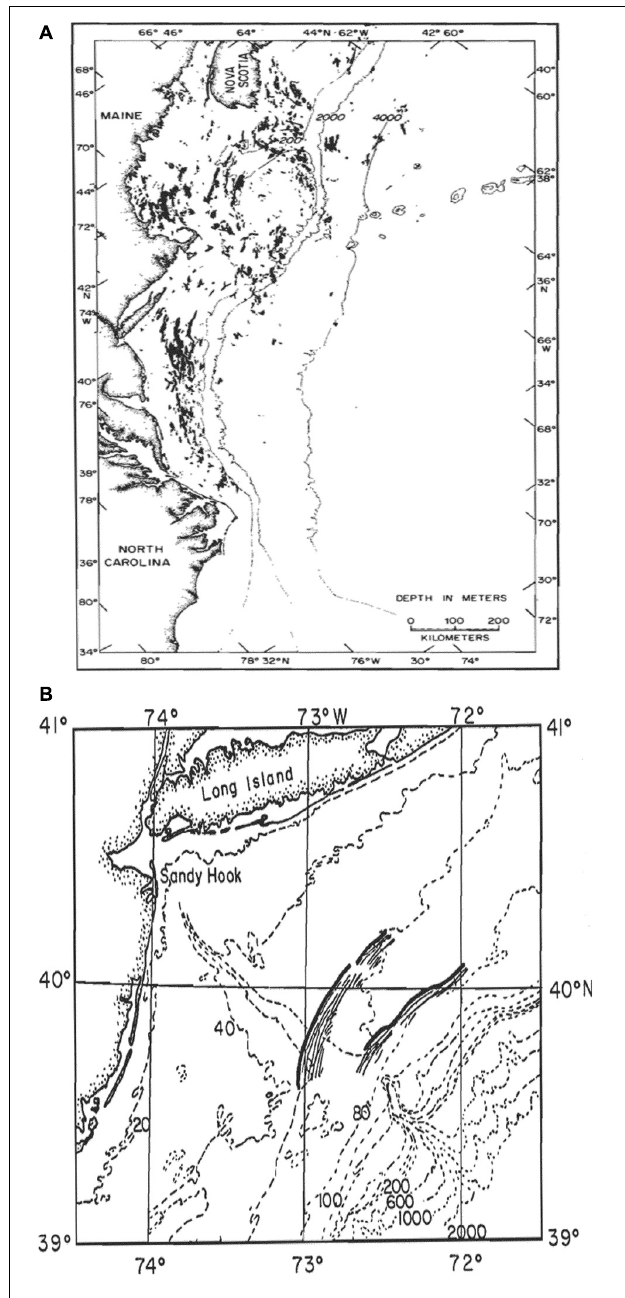
FIGURE 6 | Large tidally generated internal waves are not produced equally along a continental shelf. Waves tend to be more regularly and strongly produced along sections of the shelf break that are steeper. Images are modified from Sawyer (1983) and are part of an analysis based on Landsat images of internal wave production along the Atlantic coast of North America. (A) This image is a composite, produced from multiple Landsat images. The black blotches indicate the location of sets of internal wave convergences in the images. Notice that visible internal wave convergences are not evenly distributed. For example, there are none off the coast of Maine. (B) A close up image offshore of New York City and Long Island. The parallel lines indicate internal wave convergences. Each set of waves was produced on a different tidal exchange. Notice there are no sets to the north or south, the production of the internal waves was not evenly distributed along the